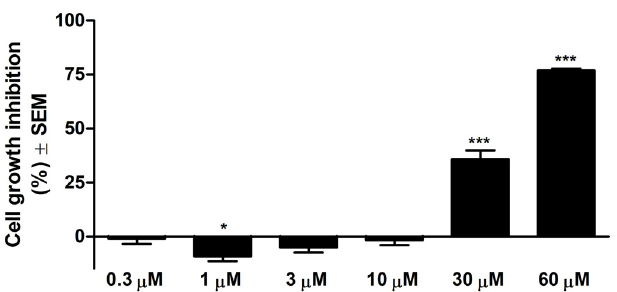
Figure 1. Cell growth inhibition (%) ± SEM against A375 human melanoma cells after 72 h of incubation with Api. * p < 0.05; *** p <